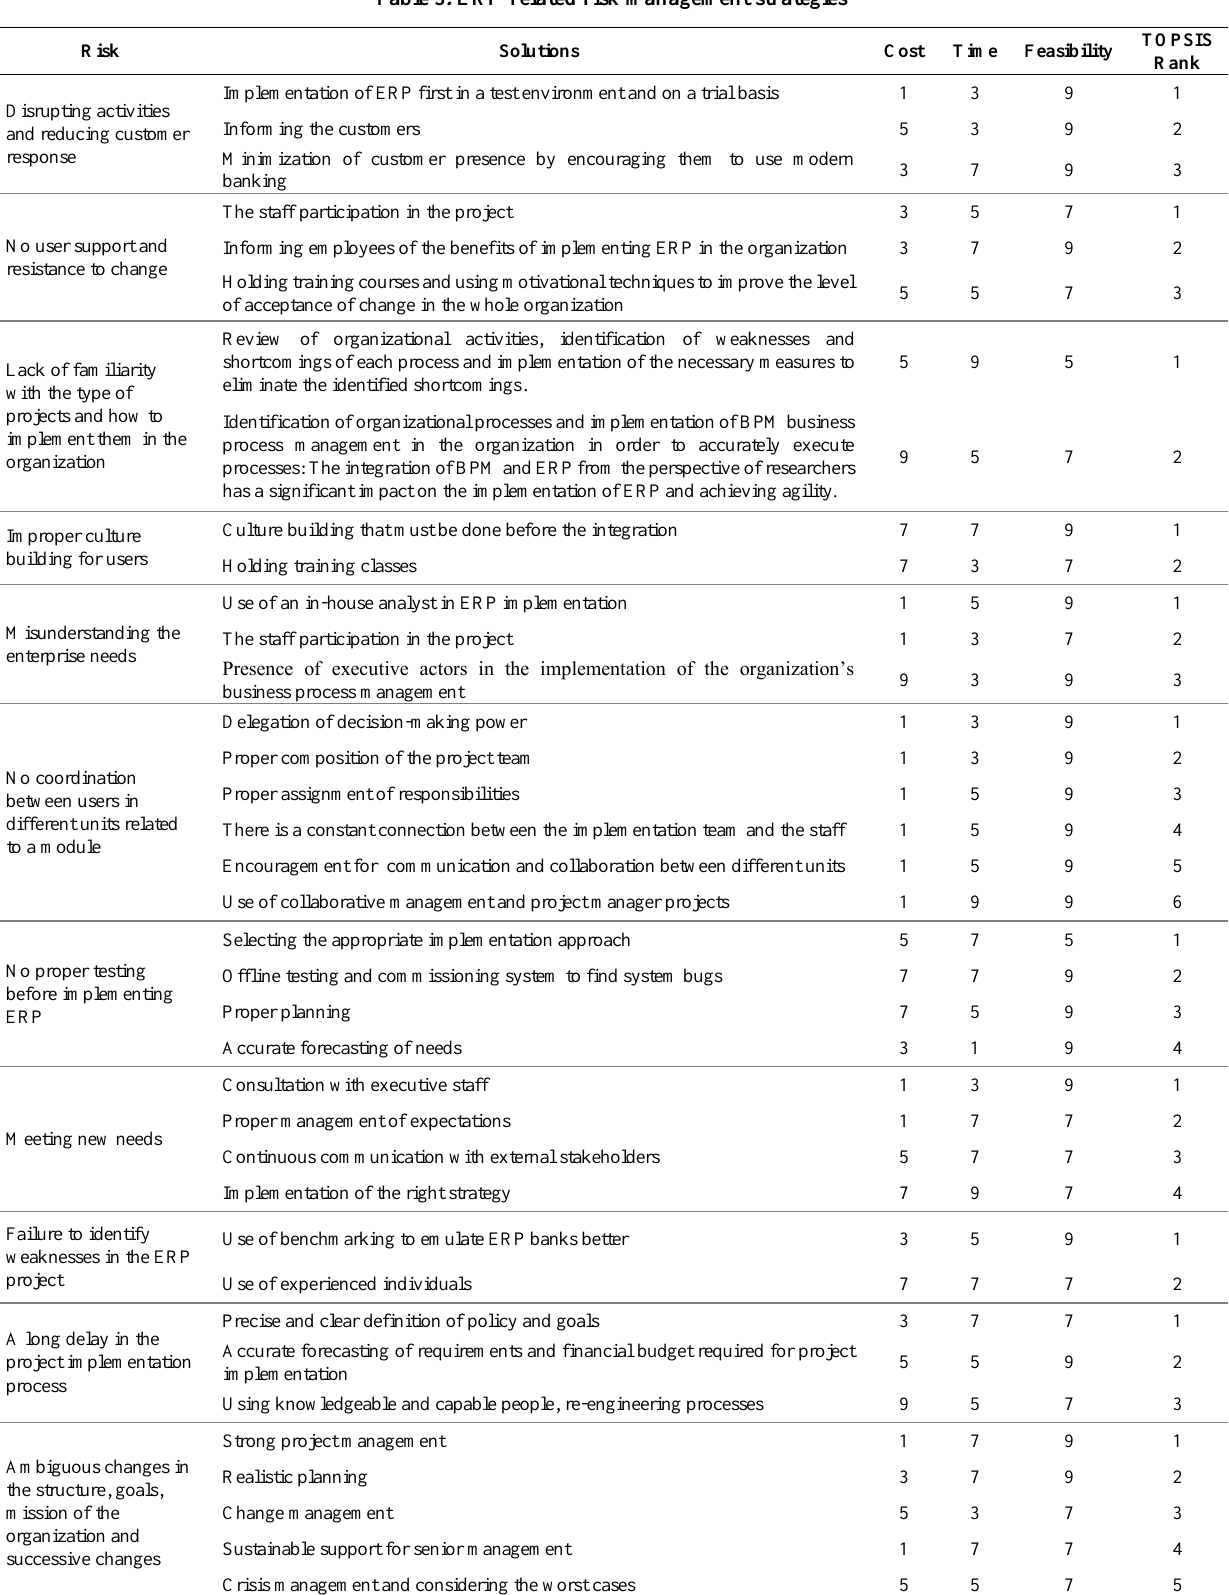
Table 3. ERP-related risk management